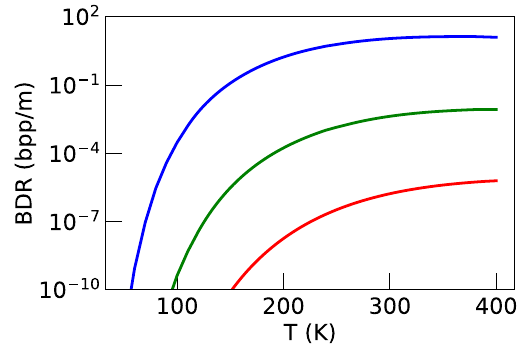
FIG. 11. BDR as a function of the temperature for the nominal parameter set, calculated using the metastable approximation [Eq. (18)]. The lines, from bottom to top, are for fields of 180, 220, and 260 MV = m.